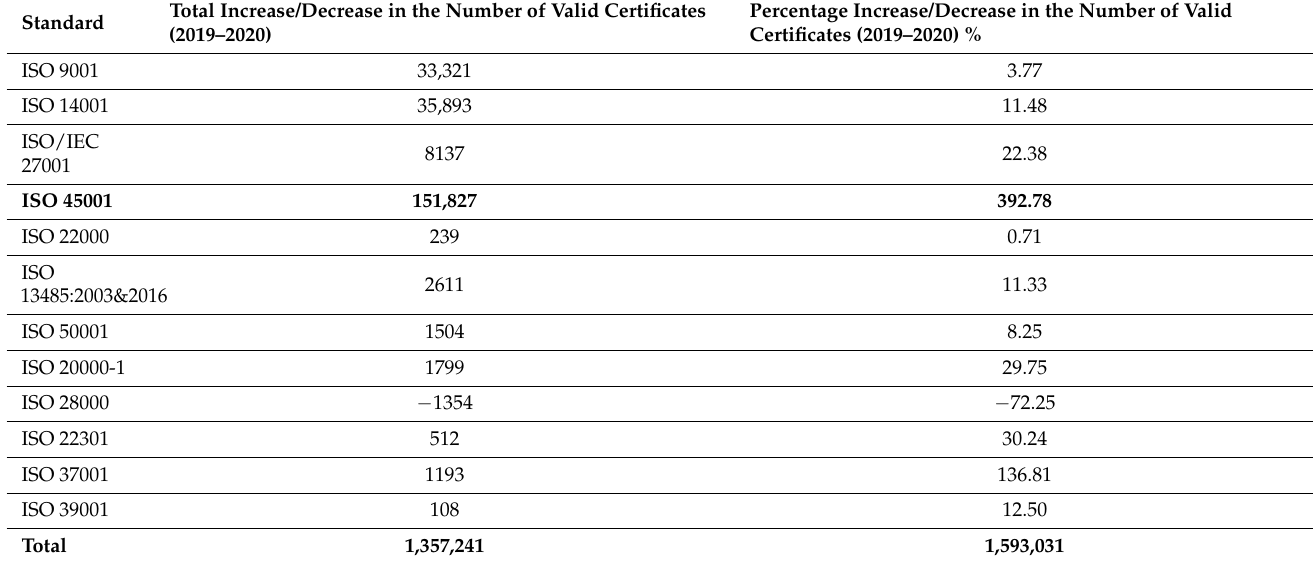
Table 3. Total and percentage increase/decrease in the number of valid certificates worldwide (comparing 2019 and 2020)